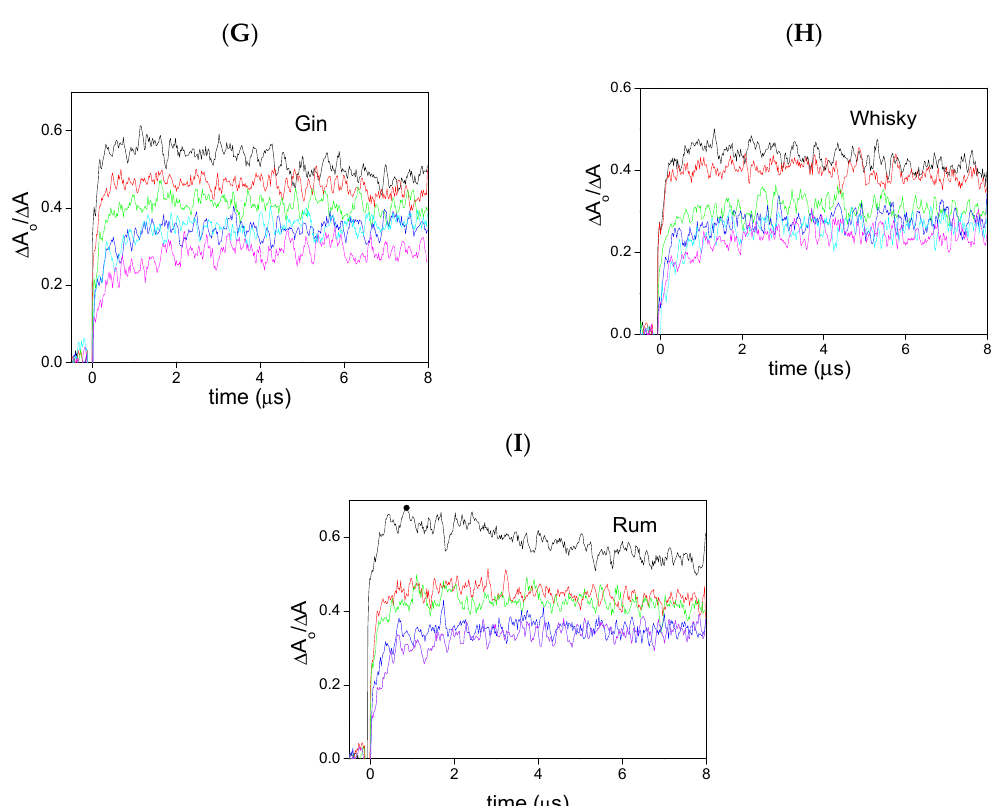
Molecules 2019 , 24 , x FOR PEER REVIEW 6 of 10 Figure 2. Kinetic traces recorded at 390 nm after laser flash photolysis irradiation ( λ exc = 355 nm) of deaerated acetonitrile solutions of NPT (0.29 mM) and TS (7.5 mM) with increasing volumes of beverages (0–0.5 mL): red wine ( A ), white wine ( B ), white vermouth ( C ), marc ( D ), brandy ( E ), triple sec ( F ), gin ( G ), whisky ( H ), and rum ( I ).